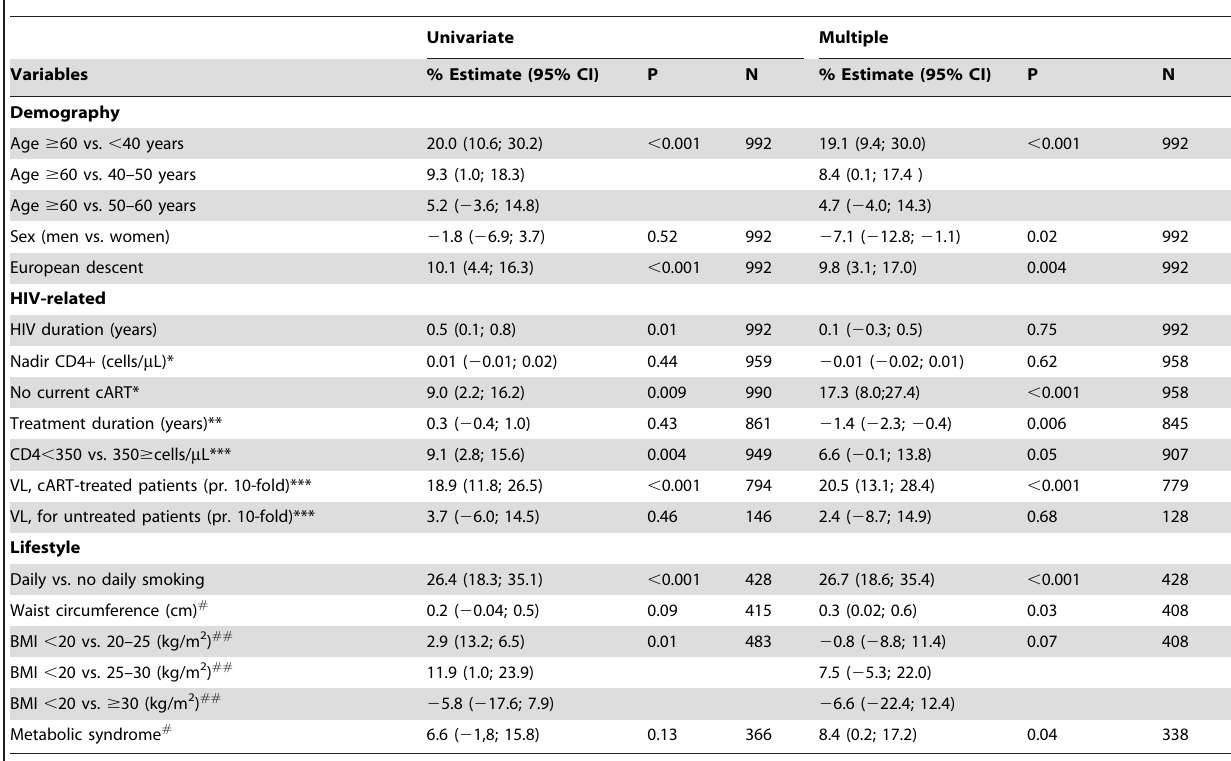
Table 2. HIV- and non HIV-related factors influencing suPAR levels.